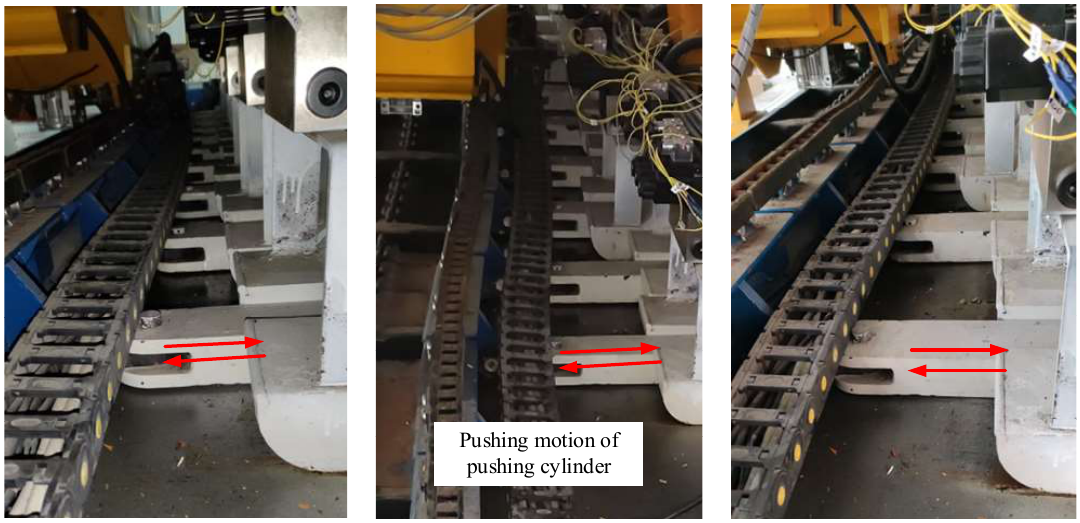
Figure 23. Following motion experiment of the pushing cylinder of hydraulic support.